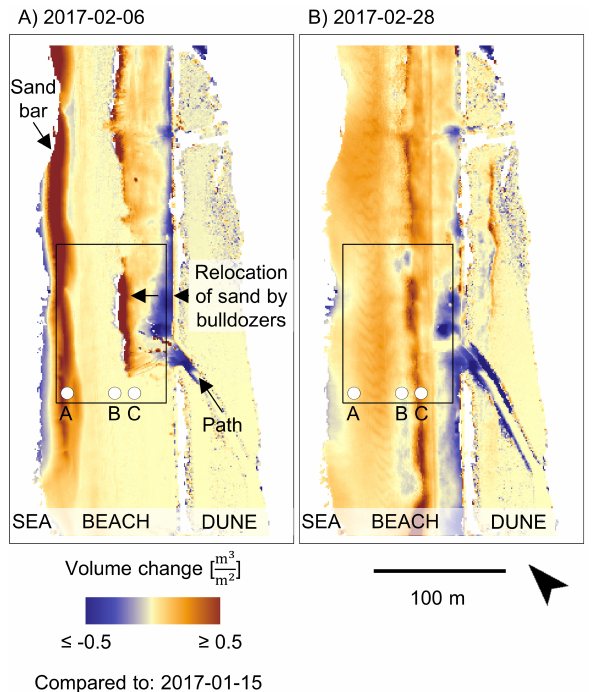
Figure 6. Volume change for a period of (A) three weeks and (B) six weeks as DTM difference to the reference. Points A-C mark the locations used for the time series assessment (Sec- tion 3.3). The black rectangle marks the area used to assess the volume budget at different observation intervals (Section 3.3.3)